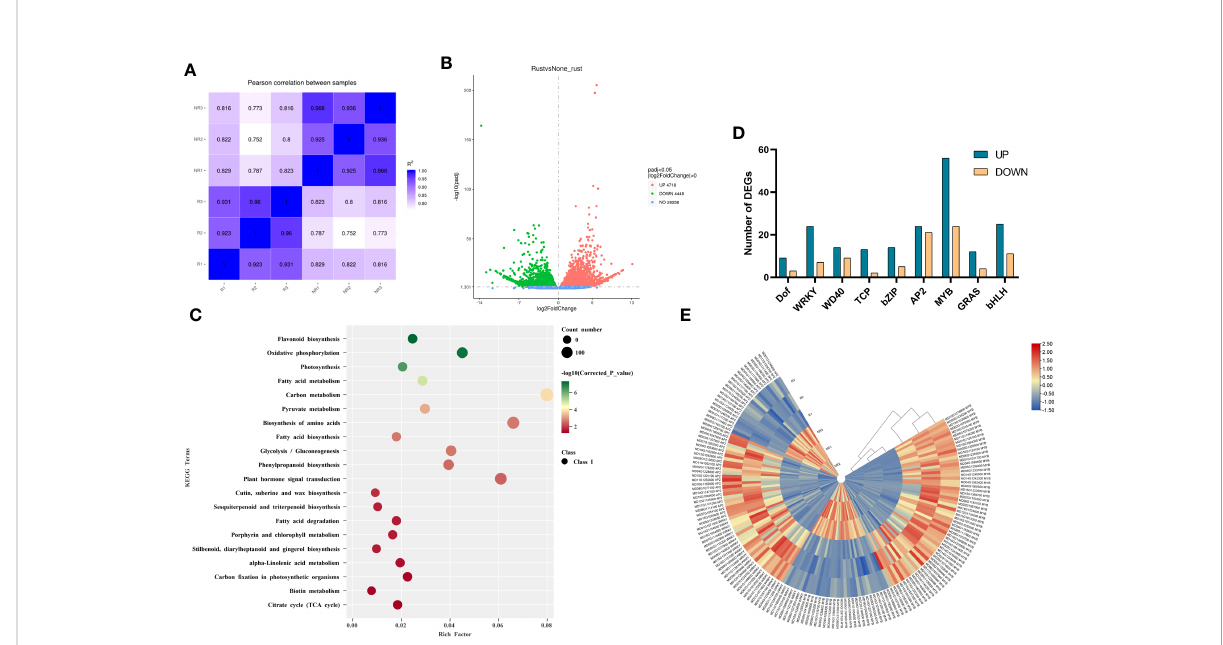
FIGURE 2 Identi fi cation and functional characterization of the DEGs in the two fruits. (A) Heatmap showing Pearson correlation coef fi cients between two samples. (B) Volcano plot fi ltering identi fi ed DEGs in the russet and non-russet fruit skin. (C) KEGG enrichment analysis of the DEGs in the two fruits. (D) Classi fi cation of transcription factors. (E) Expression heatmap of DEGs related to MYBs, WRKYs and